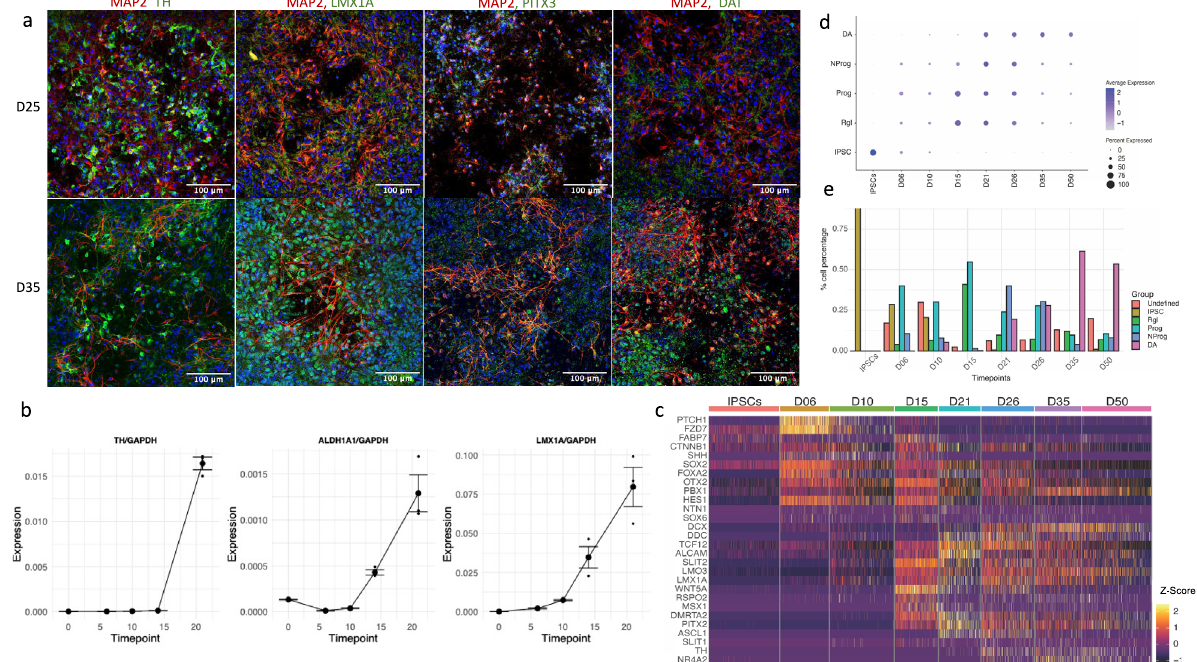
Fig. 3 In vitro differentiation of iPSC-derived mDA neurons recapitulates the in vivo process. a To illustrate the maturation of neuronal morphology and mDA status, differentiated neurons were stained at D25 and D35 for a neuronal marker MAP2 (red) and mDA markers (green): TH, PITX3, LMX1A, and DAT. While D25 neurons show short processes and low expression of mDA markers, D35 neurons show much longer axons and well-de fi ned expression of mDA markers (green/red overlap resulting on orange/yellow). b Quantitation of mDA markers TH, ALDH1A1 , and LMX1A , using absolute quantitation via qPCR. Each timepoint represents three independently differentiated biological replicates, ampli fi ed in duplicate. Standard error (SE) bars are the SE of biological replicates. The expression levels are standardized to total RNA and to the expression of the housekeeping gene GAPDH (see Methods). c Heatmap showing the expression of genes known from the literature to be involved and necessary for mDA neuron differentiation (Supplementary Table 3). Colors correlate to normalized counts ( z -score, centered, and scaled) of the indicated genes. d The mDA differentiation gene expression pro fi le recently published by Ásgrímsdóttir and Arenas (2020) 21 was used to show the progression during differentiation, from iPSCs to radial glia (Rgl), to progenitors (Prog) and neuroprogenitors (NProg), and to early mDA neurons (DA). Genes used to determine the expression modules are listed in Supplementary Table 3. e Proportions of cells expressing the various phenotypes illustrated in ( d ). The gene expression matrix obtained by SC-RNAseq used here consists of 4495 cells (see Methods